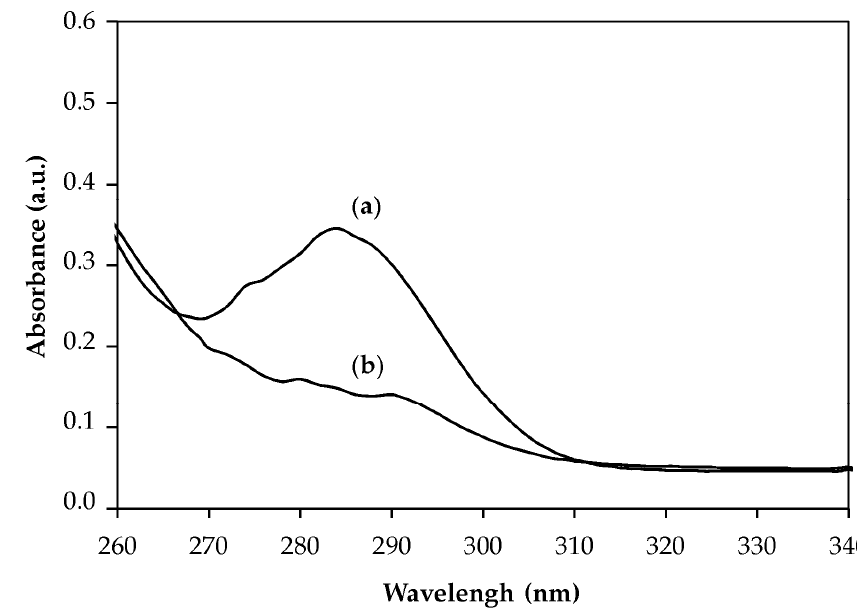
Figure 3. UV–vis spectra of the PNVCL macroinitiator before ( a , X–PNVCL–OH) and after ( b , PNVCL–OH) reaction with AIBN.